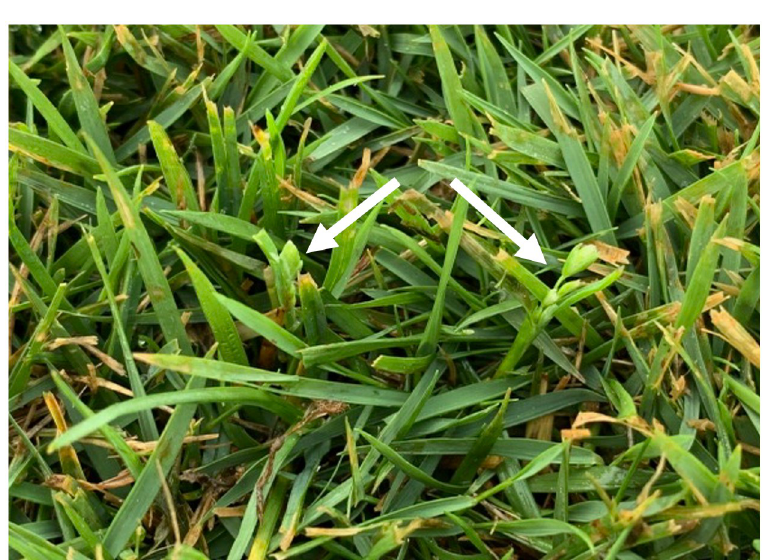
Fig 8. Poa annua plants with inflorescences on 4 August 2021 following biweekly fungicide applications in a zoysiagrass ( Zoysia matrella Merr. cv. ‘Trinity’) urban grassland located in Knoxville, TN. Without the presence of inflorescences, plants would likely be difficult to